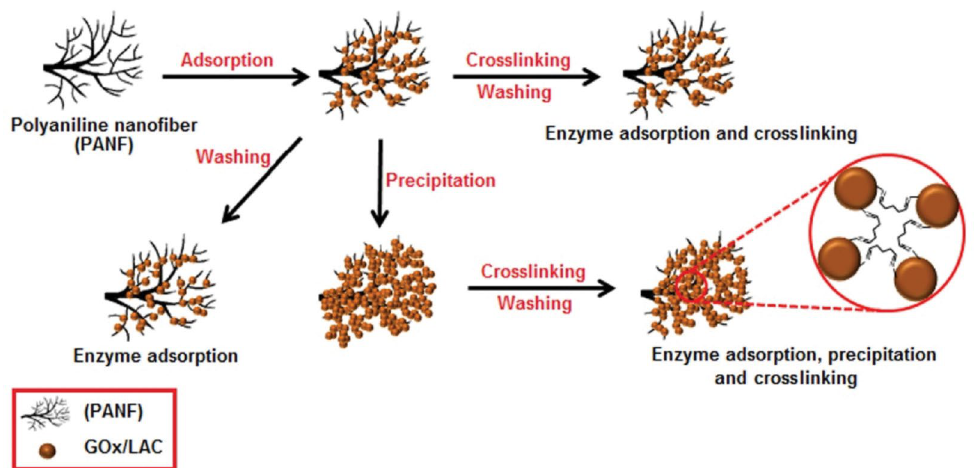
Fig. 11. Schematic illustrations of three different enzyme immobilization methods using PANFs [99]. Magnified figure of enzyme adsorption, precipitation and crosslinking represents crosslinking between enzymes